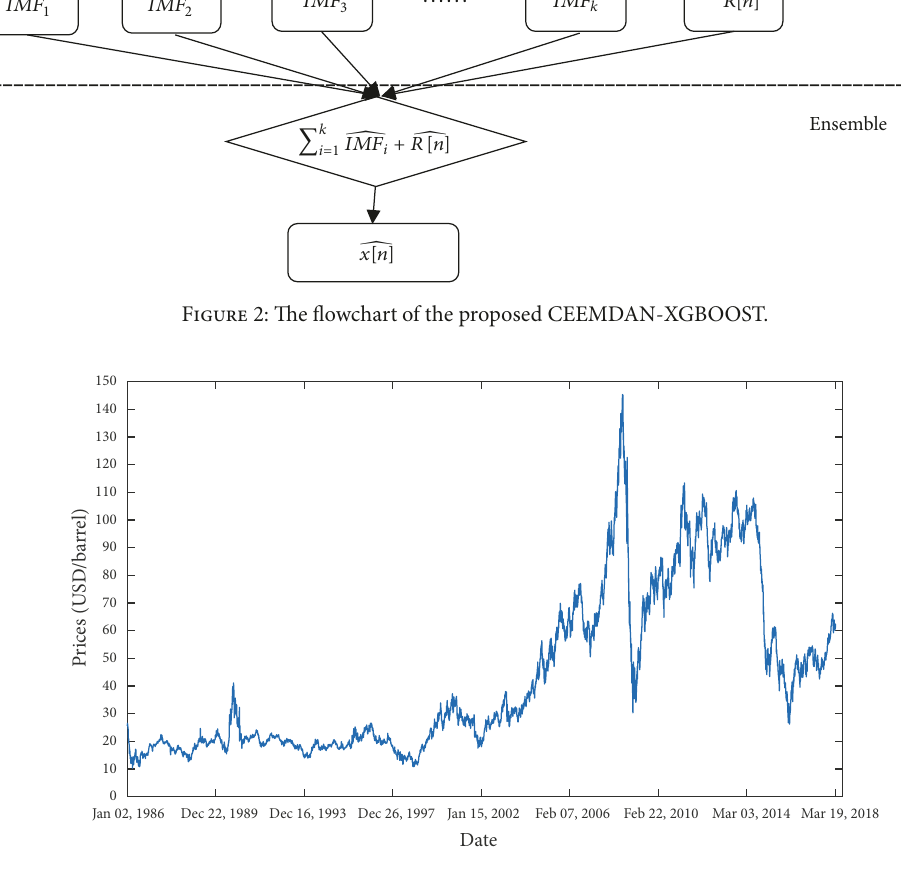
Figure 3: The original crude oil prices of